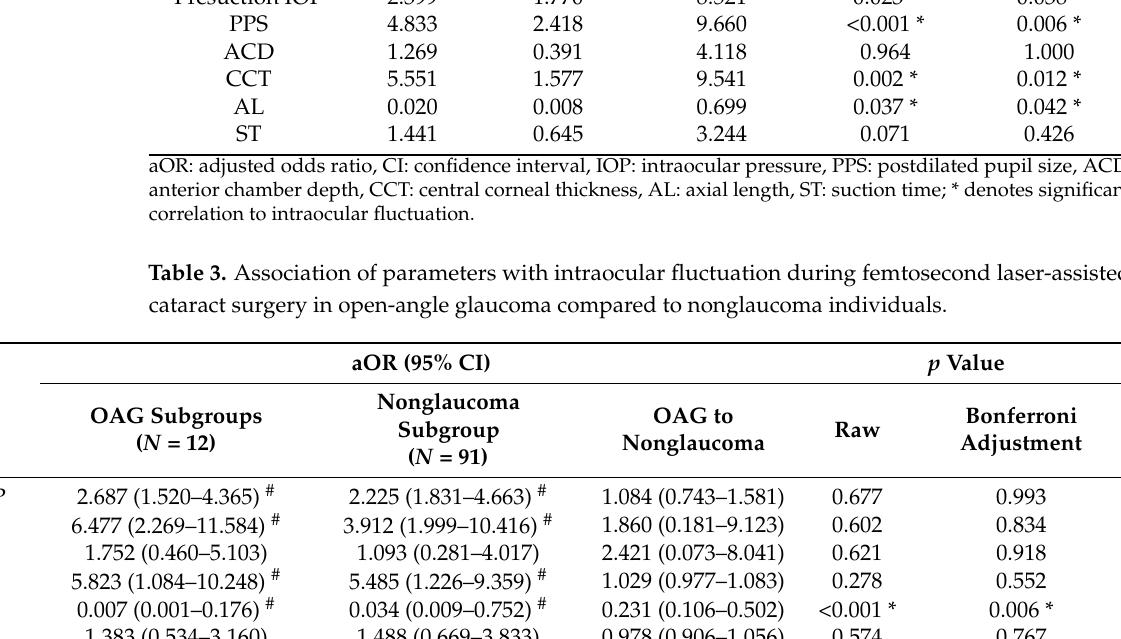
Table 2. Correlation of each parameter to intraocular fluctuation during femtosecond laser-assisted cataract surgery. 95% CI p Value Parameters aOR Lower Limit Upper Limit Raw Presuction IOP